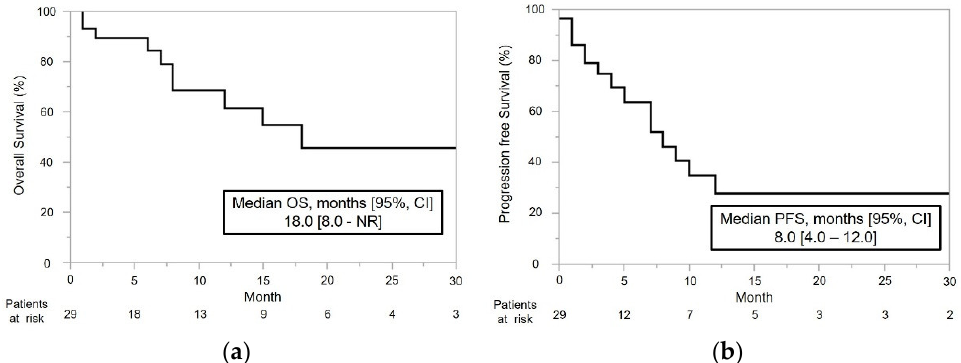
Figure 2. Overall survival (OS) and progression-free survival (PFS) from the date of the first molecular-targeted therapy in patients who discontinued nivolumab plus ipilimumab combination therapy. The median overall survival (OS) and progression-free survival (PFS) were ( a ) 18 months and ( b ) 8 months, respectively.